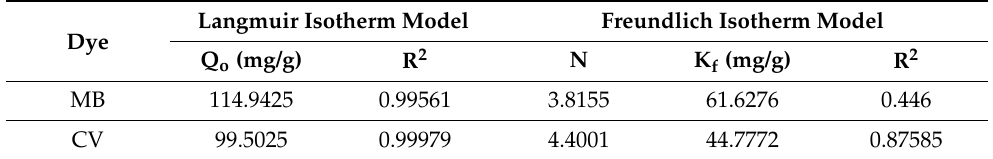
Table 3. Adsorption isotherms parameters for the sorption of MB and CV-dyes on modified biochar. Dye